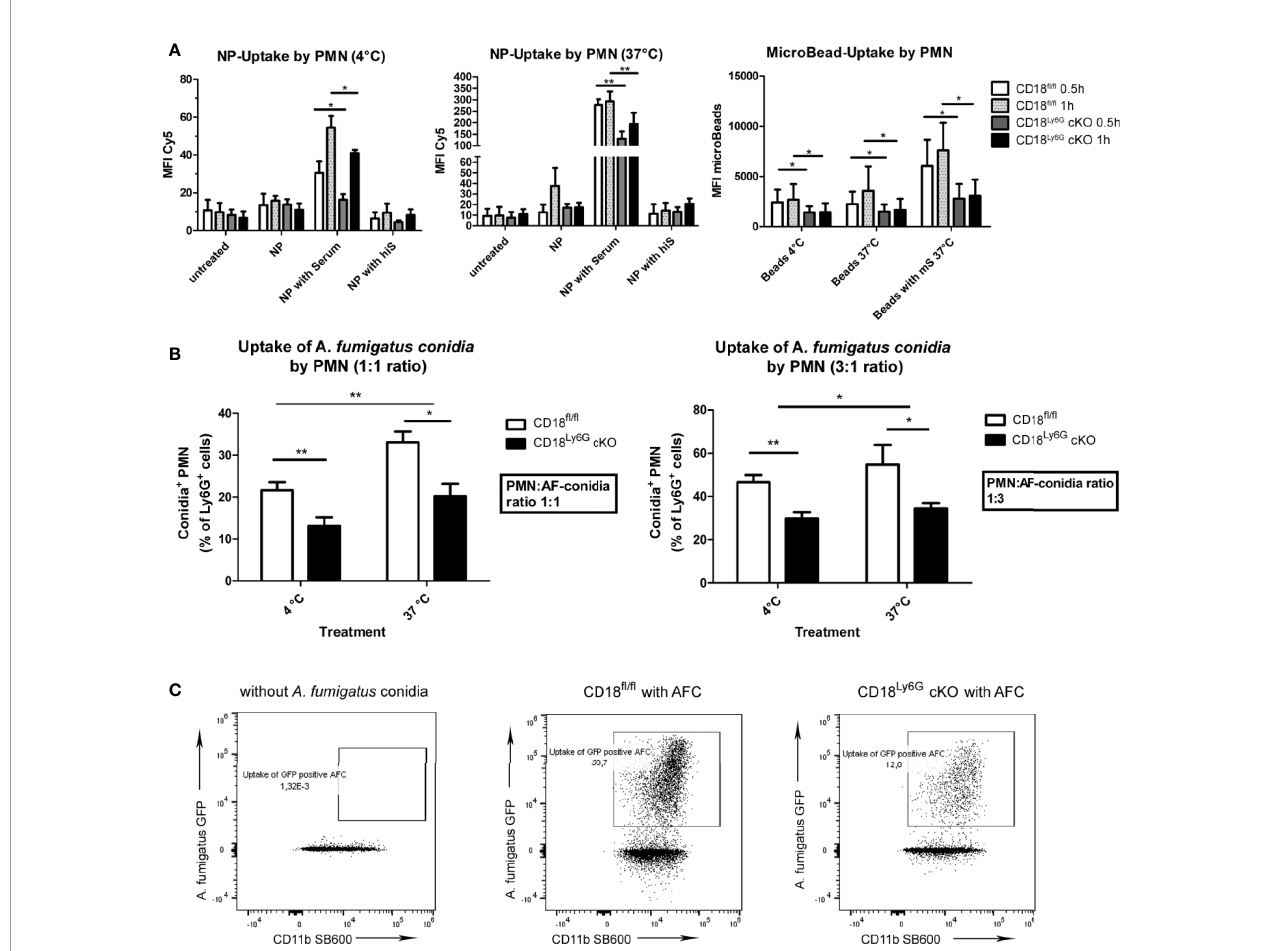
FIGURE 6 | Phagocytosis of inert particles and fungal conidia is less effective in PMN of CD18 Ly6G cKO mice. Freshly isolated PMN were co-incubated either with nanoparticles (NP), microBeads (A) or with GFP- fl uorescent A. fumigatus conidia (AFC) at 37°C with indicated ratios (B) . Simultaneous co-incubation at 4°C served to differentiate mere adhesion from temperature-dependent binding. After 30 min and 60 min the frequency of either Cy5 positive NP, PE-positive microBeads (A) , or GFP-positive PMN (B) was determined by fl ow cytometry. Data represent the mean ± SEM of 3 samples analyzed/group. Exemplary fl ow cytometry data depicting the diminished uptake of GFP- fl uorescent conidia by PMN from CD18 Ly6G cKO mice are shown in (C) . Statistically signi fi cant differences between groups are indicated (*p<0.05,